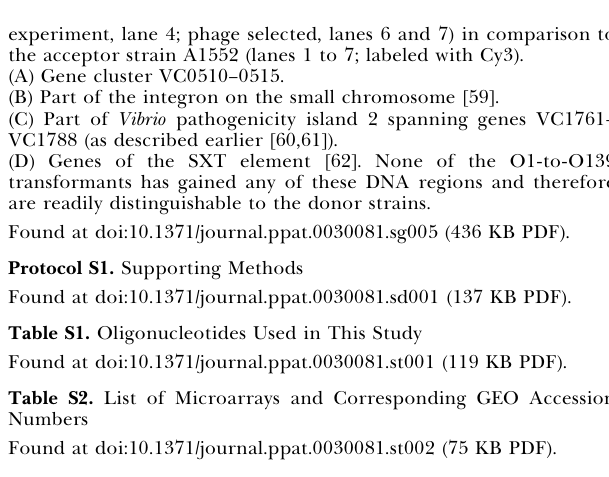
Figure S2. Schematic Representation of V. cholerae Serogroup Conversion by Chitin-Induced Transformation in Mixed